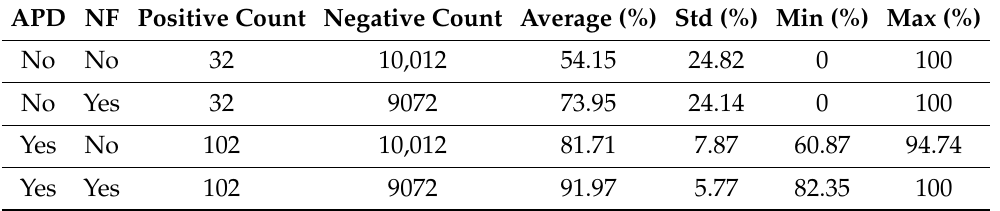
Table 3. Number of training samples and F 1 scores after cross validation. APD: Added positive validated data, NF: negative filtering.